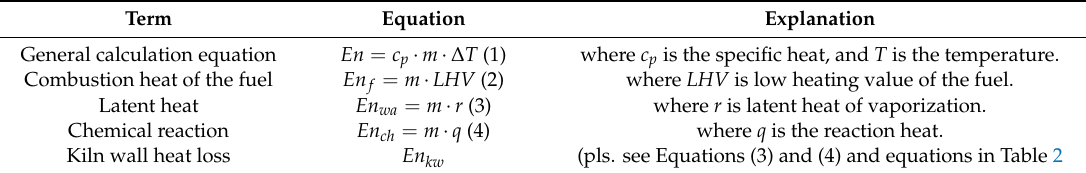
Table 1. Equations used in energy